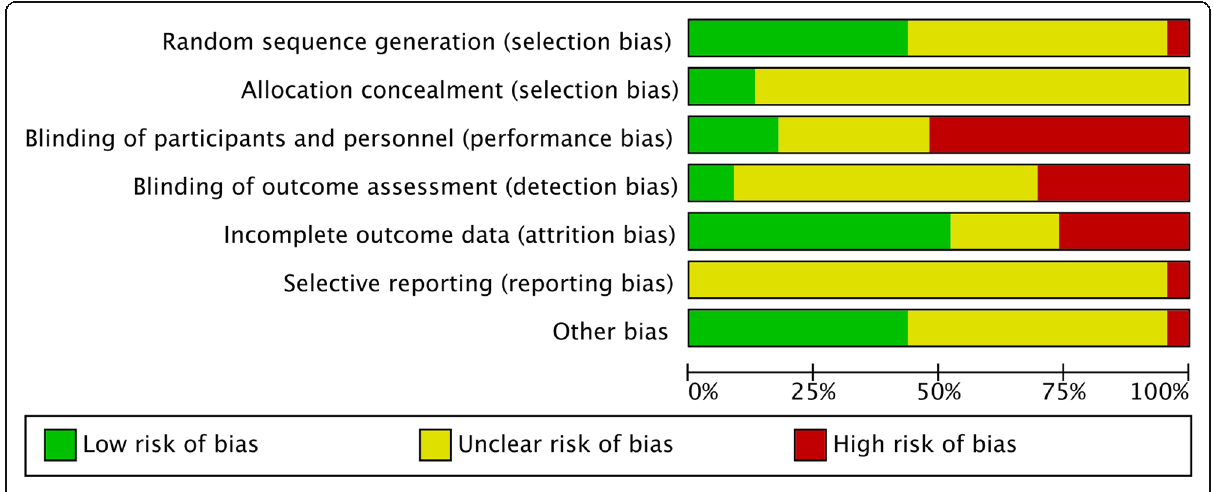
Fig. 2 Summary of risk of bias across